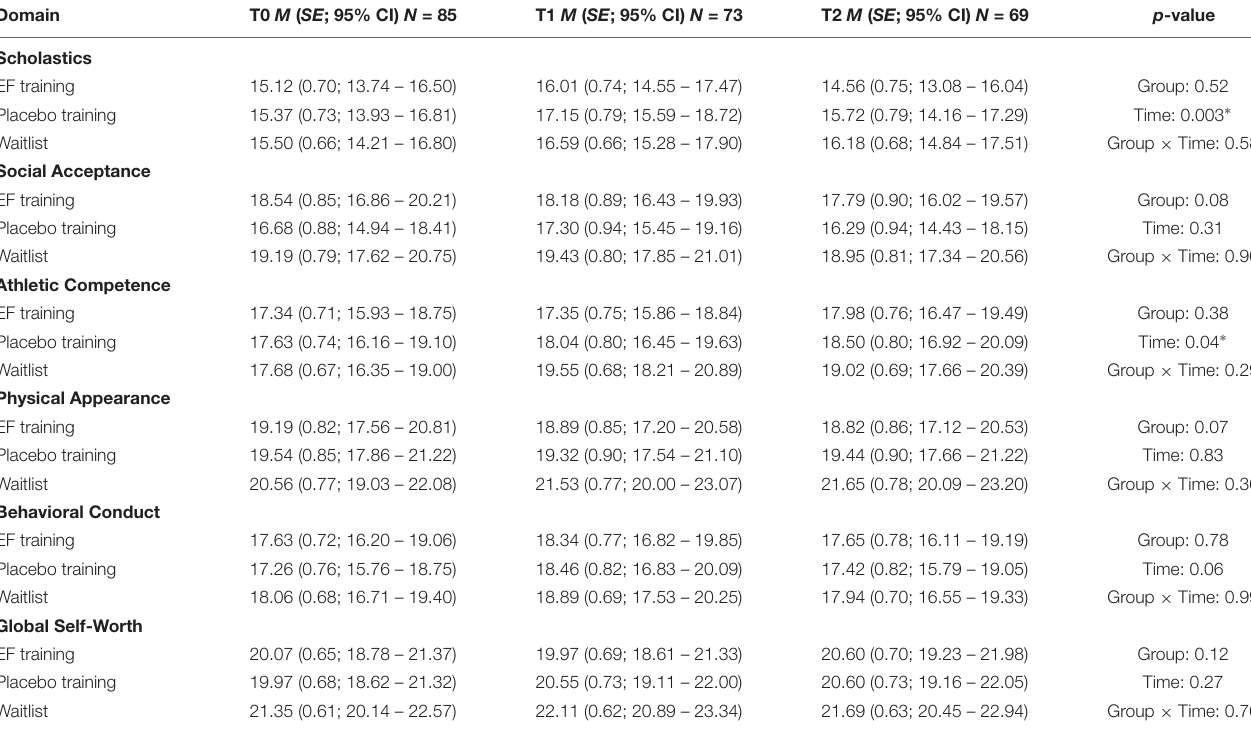
TABLE 5 | Baseline and follow-up data on self-perceived competence for the three treatment groups.